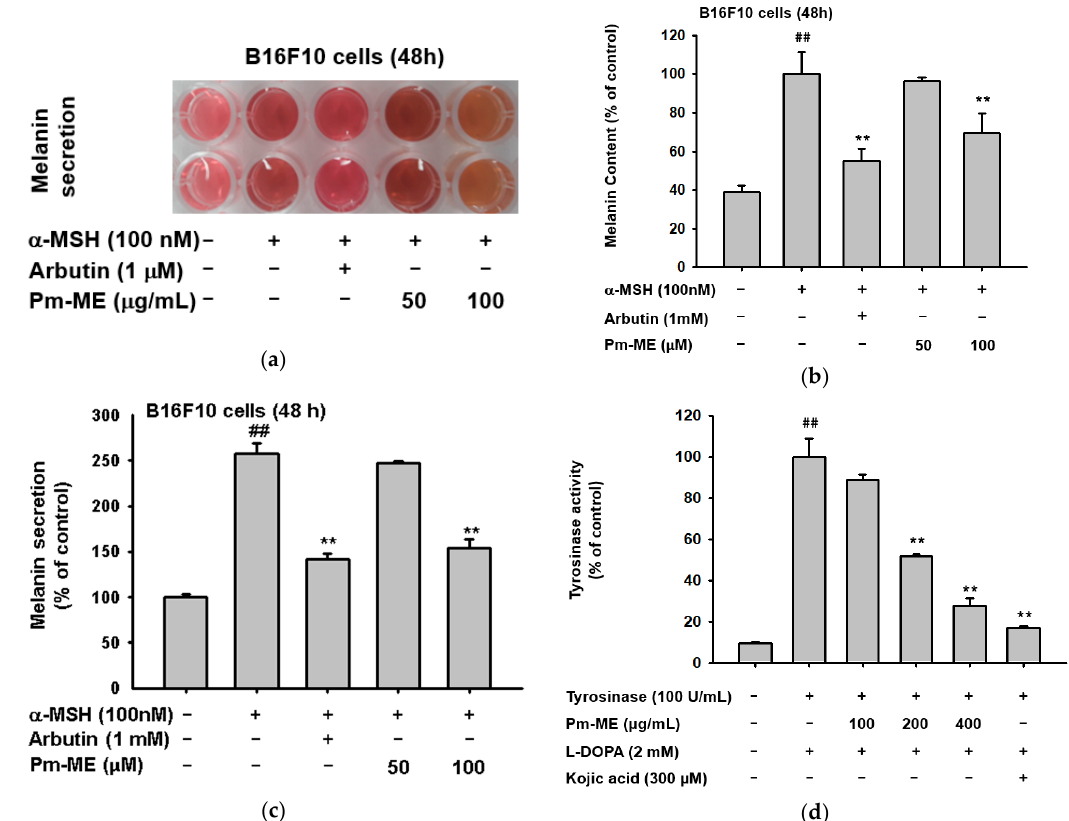
Figure 4. The effect of Pm-ME on melanogenesis in α -melanocyte stimulating hormone (MSH)- stimulated B16F10 cells. ( a – c ) B16F10 cells (1 × 105 cells/mL) were treated with α -MSH in the presence or absence of Pm-ME (0–100 µg/mL) or 1 mM arbutin for 48 h. Melanin content was determined